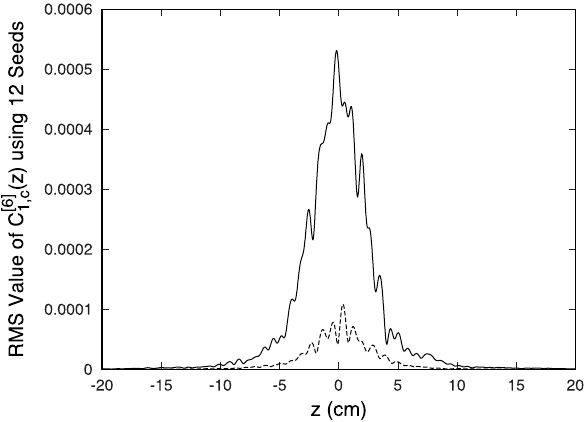
FIG. 19. The function C ½ 6 (cid:3) 1 as computed from a mesh contain- ;c ing random noise (61) at each mesh point. Damping of this noise illustrates the effect of smoothing. (solid line) Result obtained using a circular cylinder with R ¼ 2 cm . (dashed line) Result obtained using an elliptical cylinder with semiminor axis of 2 cm and a semimajor axis of 4 cm.